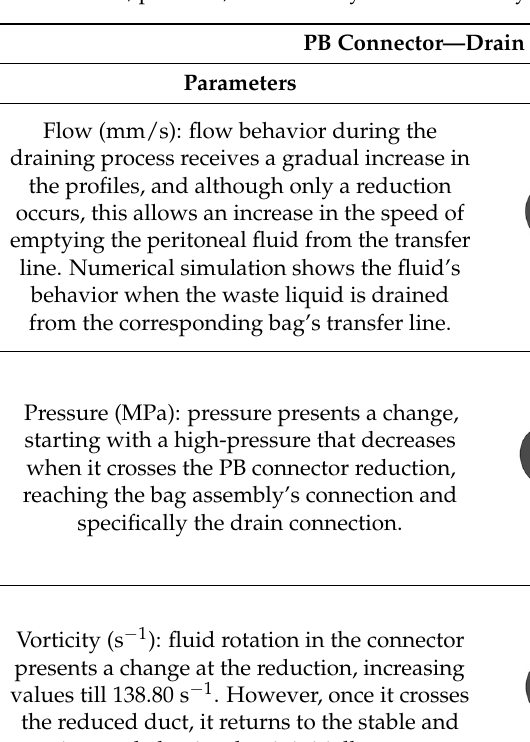
Table 6. Flow, pressure, and vorticity numerical analysis for PB connector—fluid draining process.